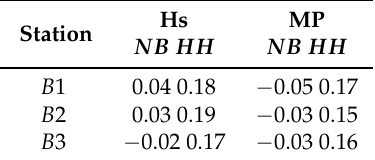
Table 1. Statistical parameters between simulated wave results and